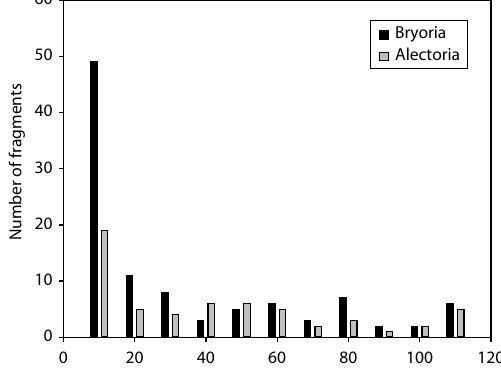
Fig. 5. Size-class distribution of Bryoria and Alectoria fragments collected from the bottoms of enclo- sures at Lucille Mountain, 1993-2000. Size class- es represent the mass of the fragment as a percent- age of the mass of the sample at the beginning of the measurement period (S. Stevenson, unpubl. data; methods in Stevenson,